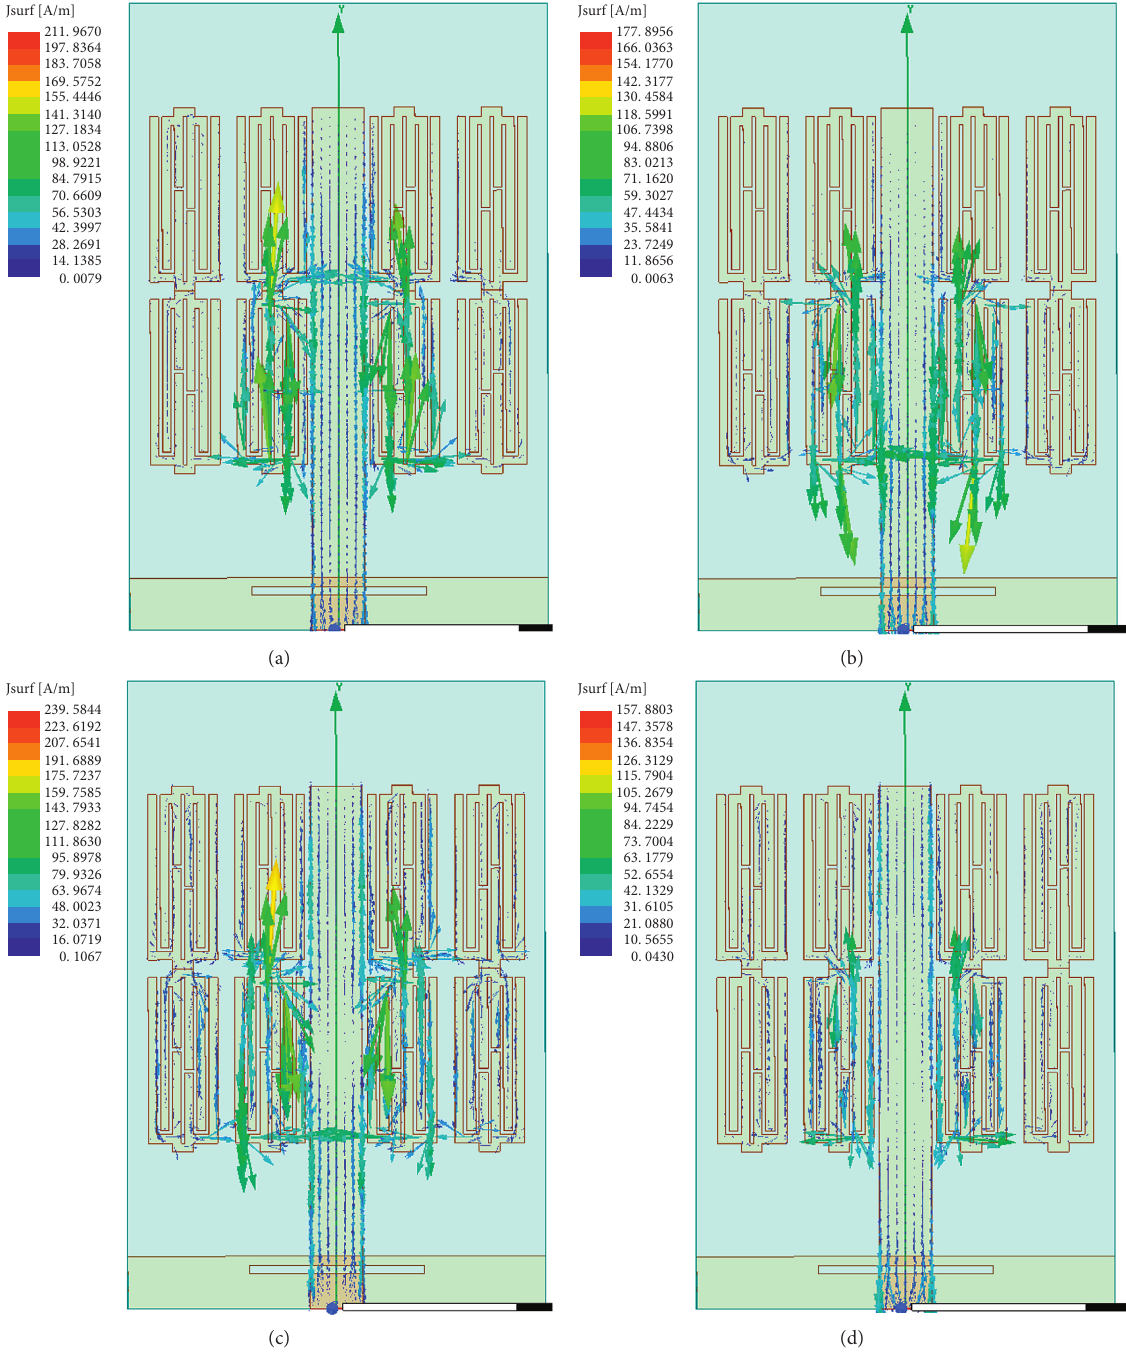
Figure 11: Current distribution at different frequencies of the proposed antenna: (a) 2.48 GHz, (b) 3.17GHz, (c) 5.27 GHz, and (d)